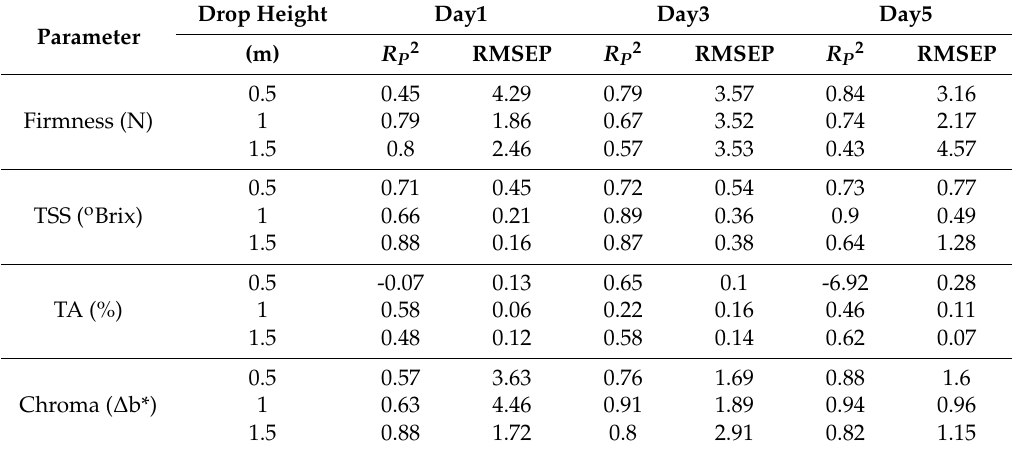
Table 2. Modeling results by PLS regression to predict PF, TSS, TA and flesh color from impact tests. Drop Height Day1 Parameter